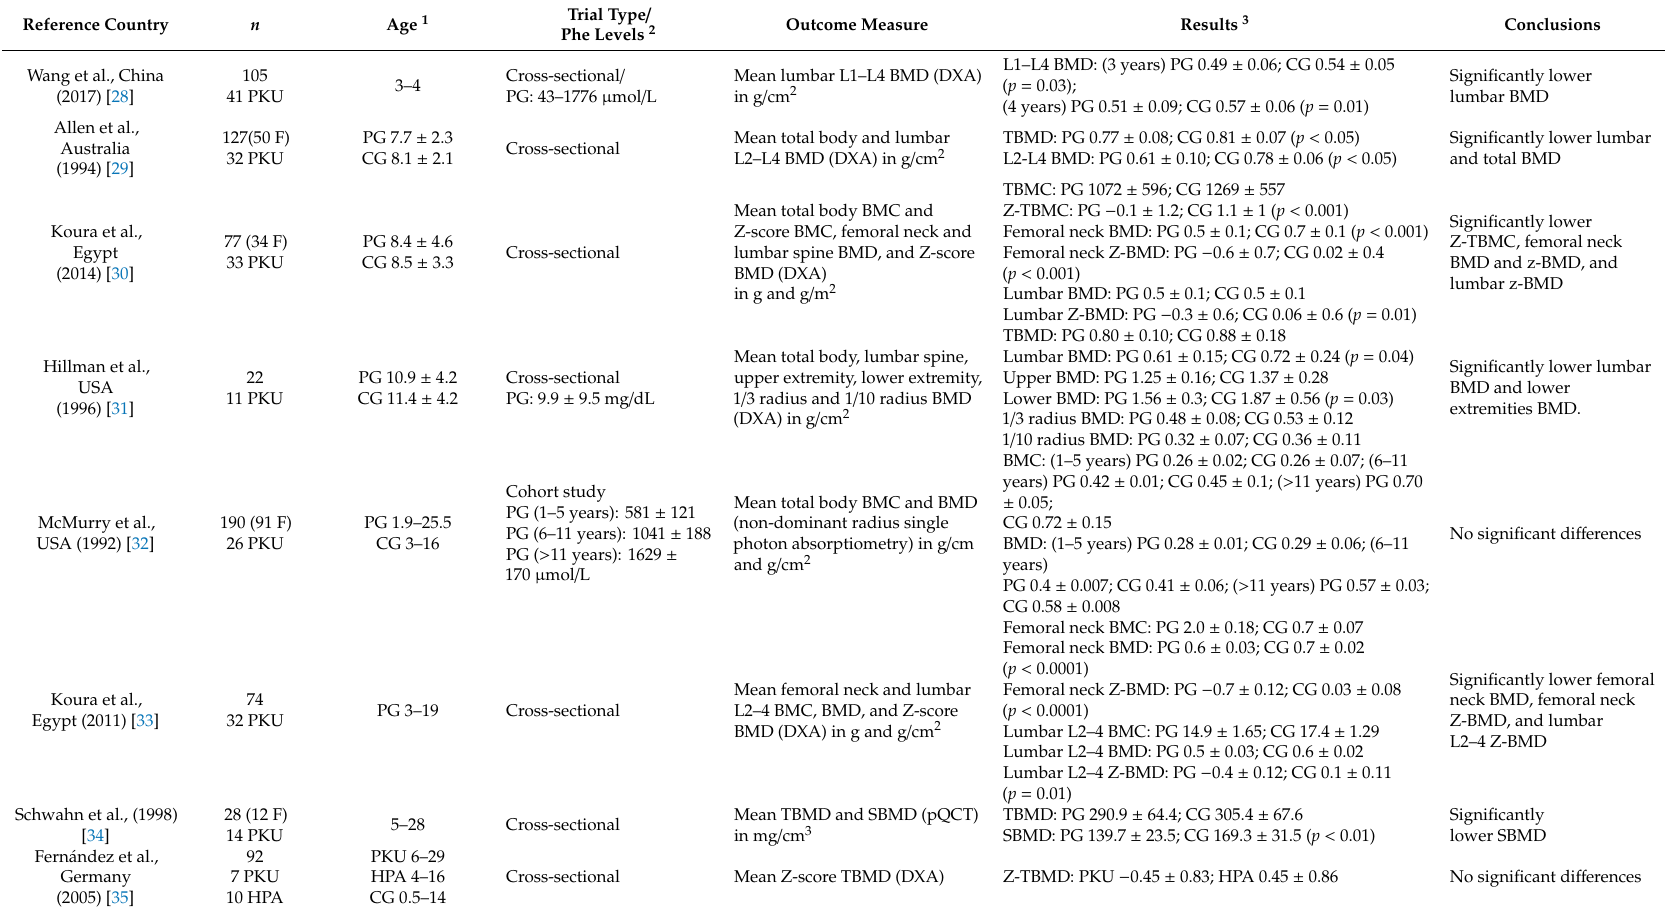
Table 1. Bone mineral content in patients with